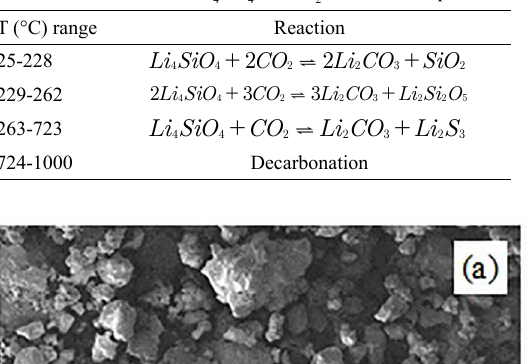
SiO and CO at different temperatures. 4 4 2